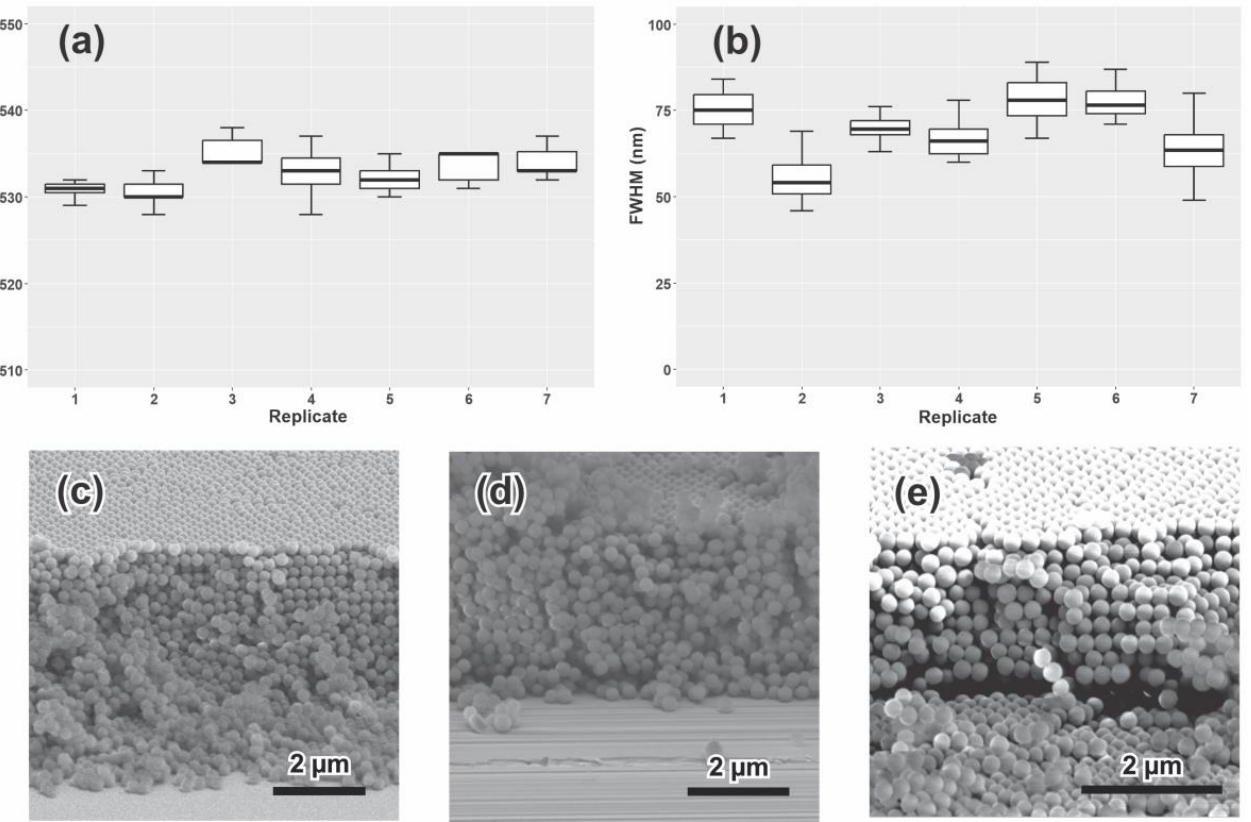
Figure 9. Max. reflectance ( a ) and FWHM ( b ) of batches elaborated for the reproducibility assay. SEM images of deposits obtained from three replicates ( c ), ( d ), and ( e ).